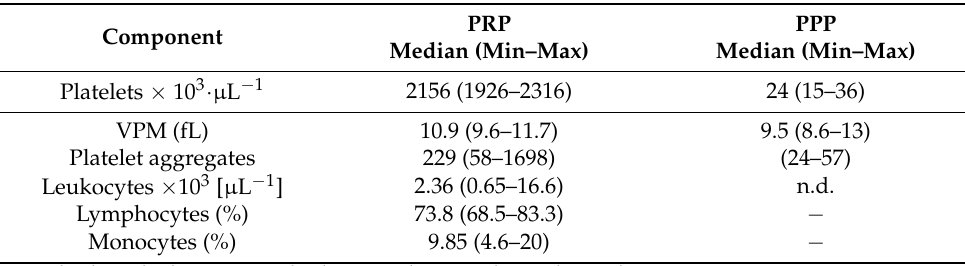
Table 1. PRP and PPP cell